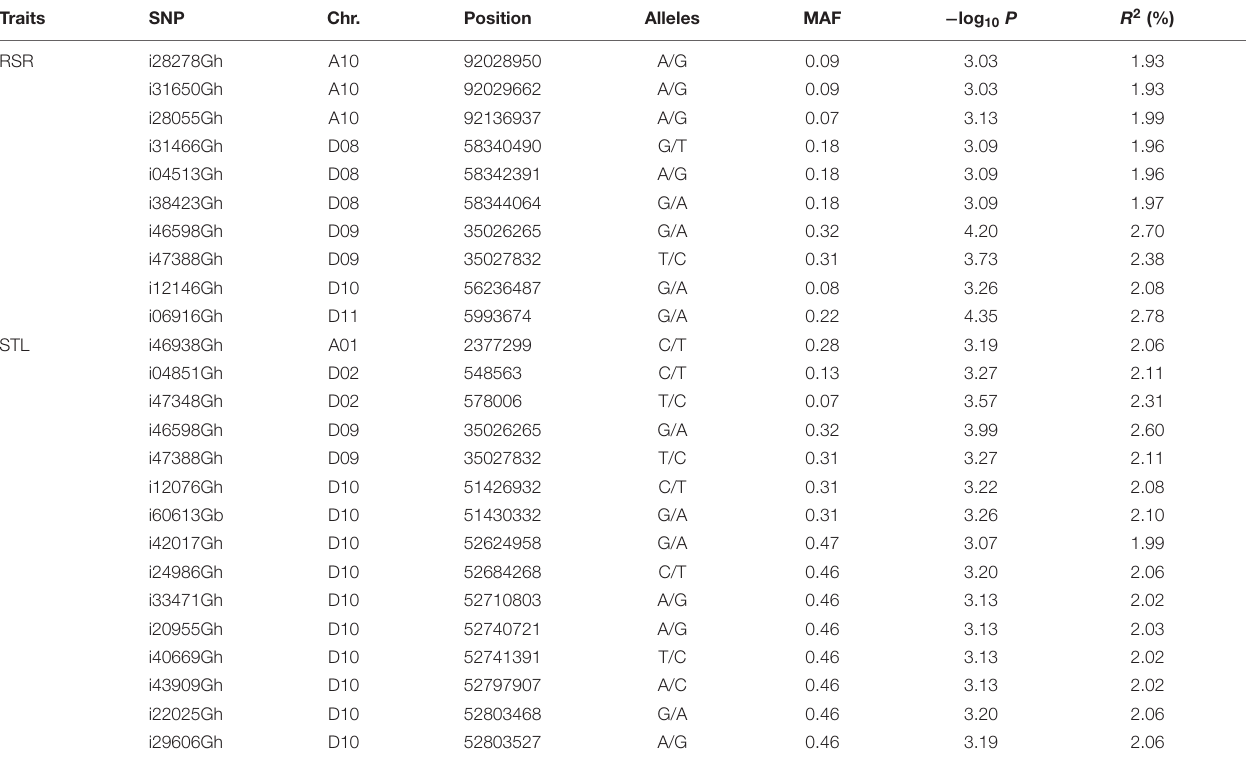
TABLE 2 | List of SNP markers significantly associated with RSR and STL in the upland cotton association panel. Traits SNP Chr. Position Alleles MAF − log 10 P R 2